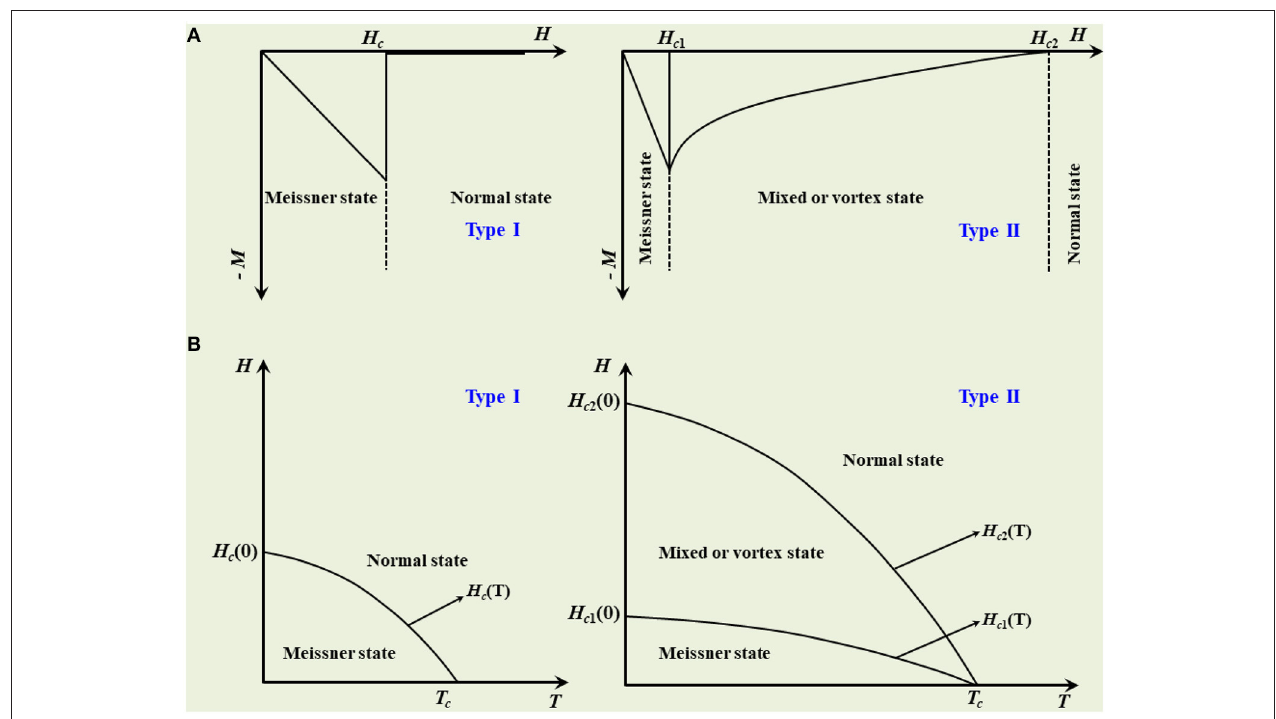
FIGURE 1 | (A) Variation of magnetization as a function of applied magnetic field for type I and type II superconductors. (B) The corresponding H-T phase diagram for type I and type II superconductors.